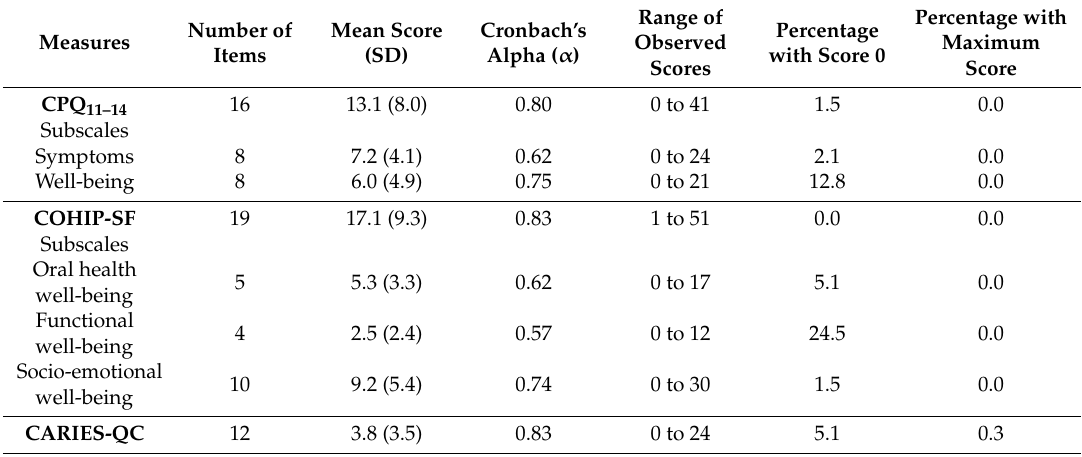
Table 2. Baseline descriptive statistics and internal consistency reliability data for the CPQ 11–14 , COHIP-SF and CARIES-QC and